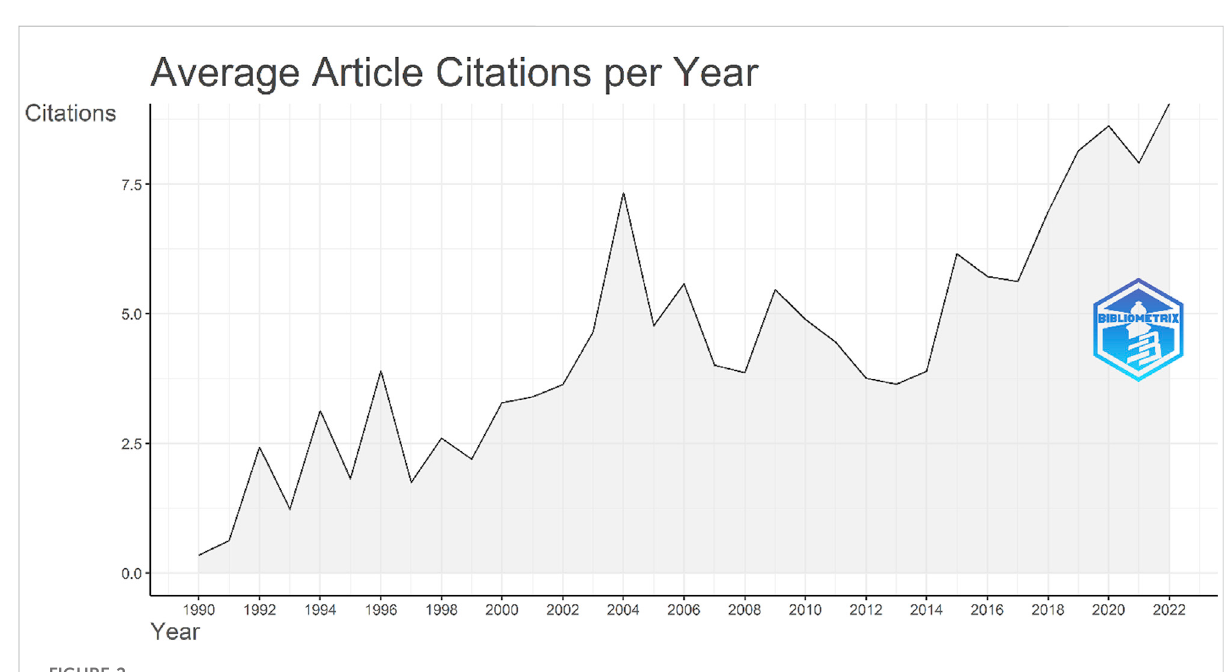
FIGURE 2 Average article citation per year. The x-axis indicates the years, while the y-axis indicates the average number of